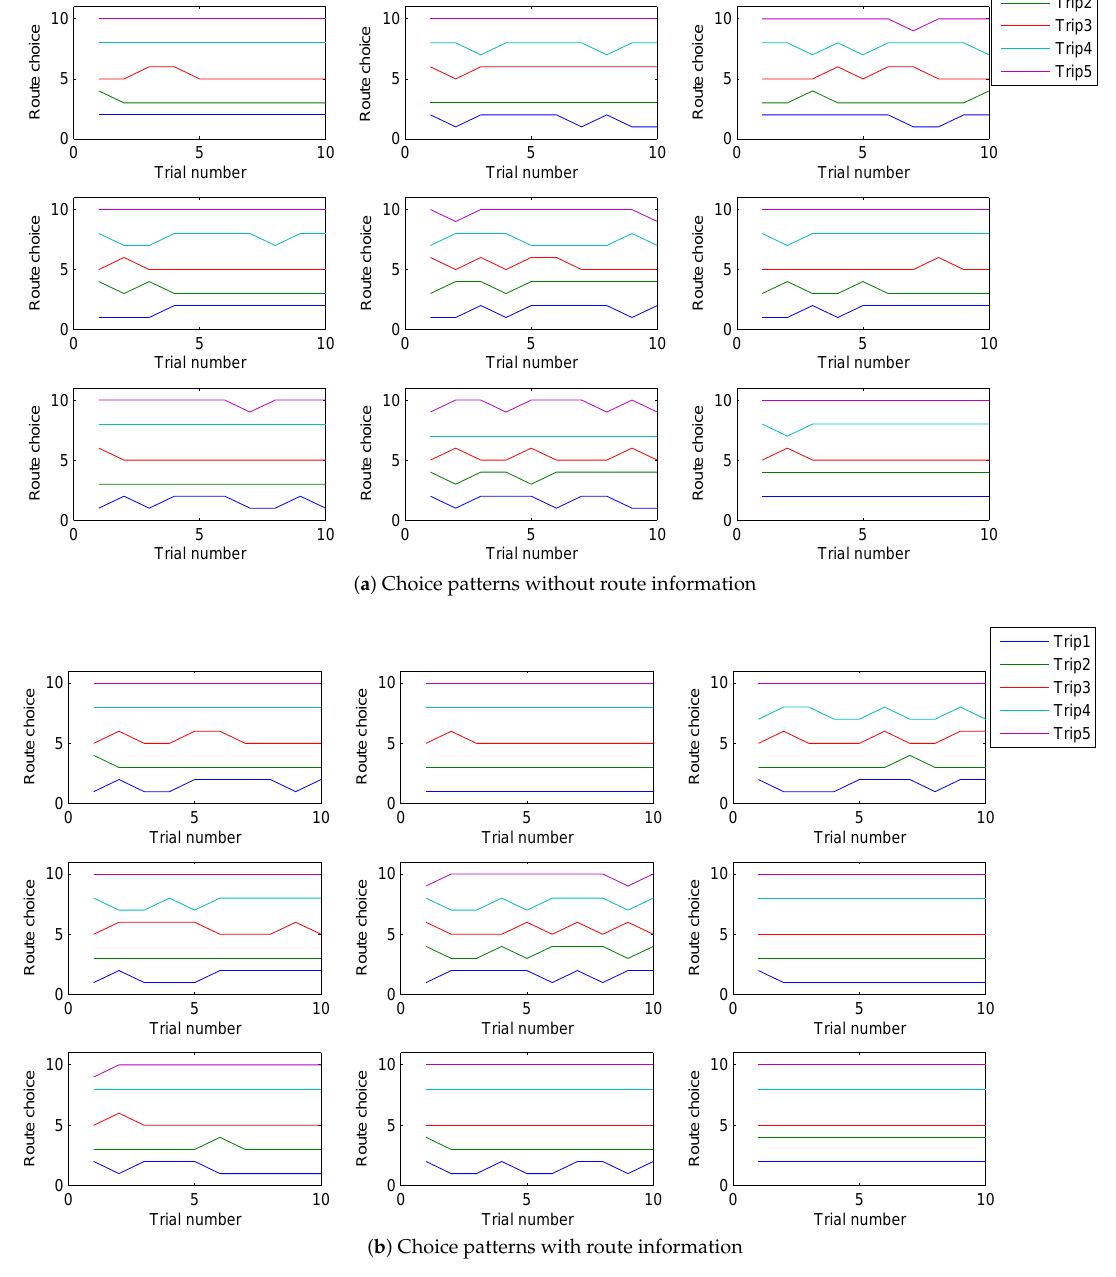
Figure 2. Participants choice patterns without vs. with route